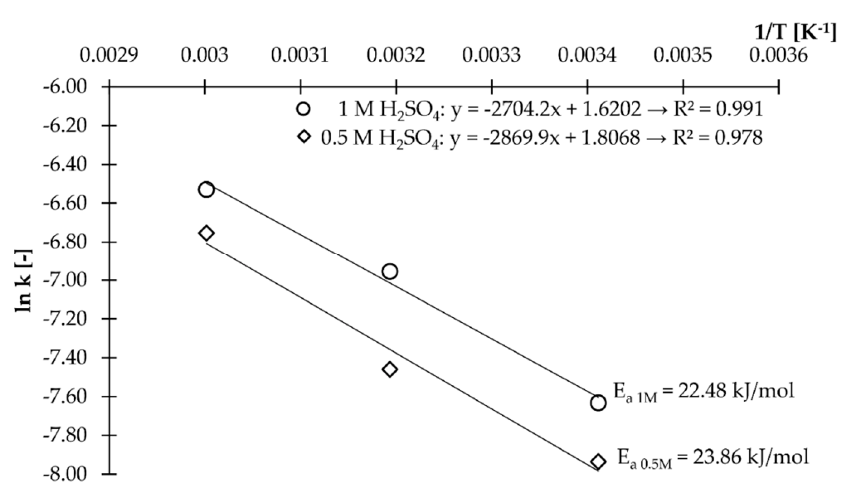
Figure 12. Apparent activation energy determination from the slope of Arrhenius plot at two different molarities of H 2 SO 4 .